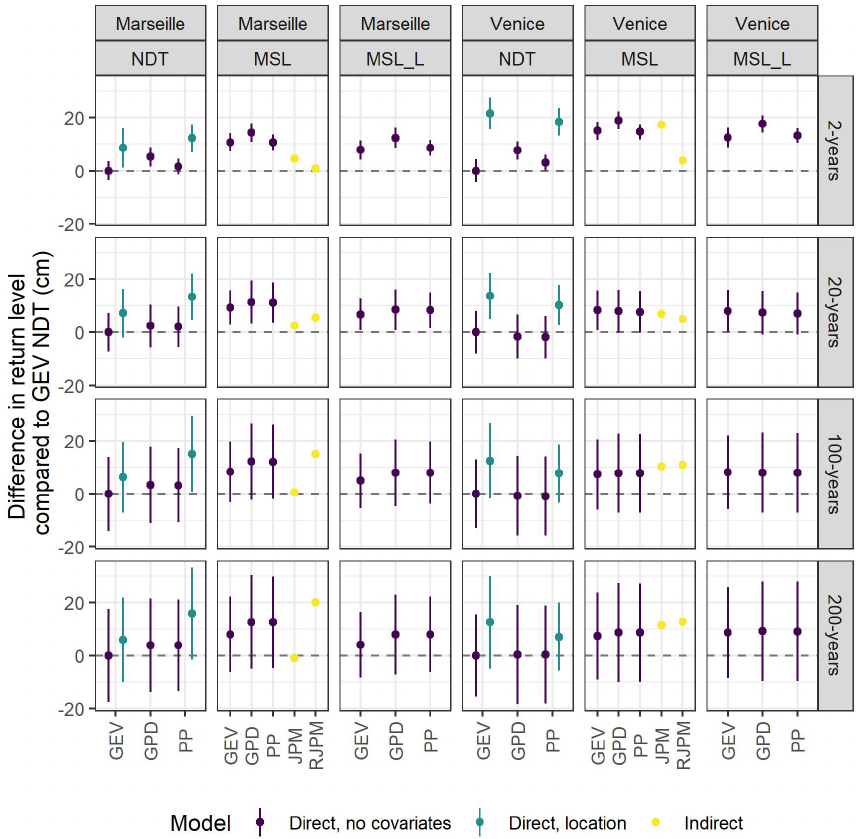
Figure 5. Difference in return levels between each fitted model and a non-detrended GEV fit for different return periods. Return levels of models with covariates are shown only if the model significantly improves the fit compared to models without covariates ( p < 0.01; see Table 2). Plots are grouped vertically according to the detrending method (MSL: mean sea level; MSL_L: long-term mean sea level; NDT: non-detrended) and horizontally according to the distribution function (GEV: generalized extreme value; GP: generalized Pareto distribution; PP: point